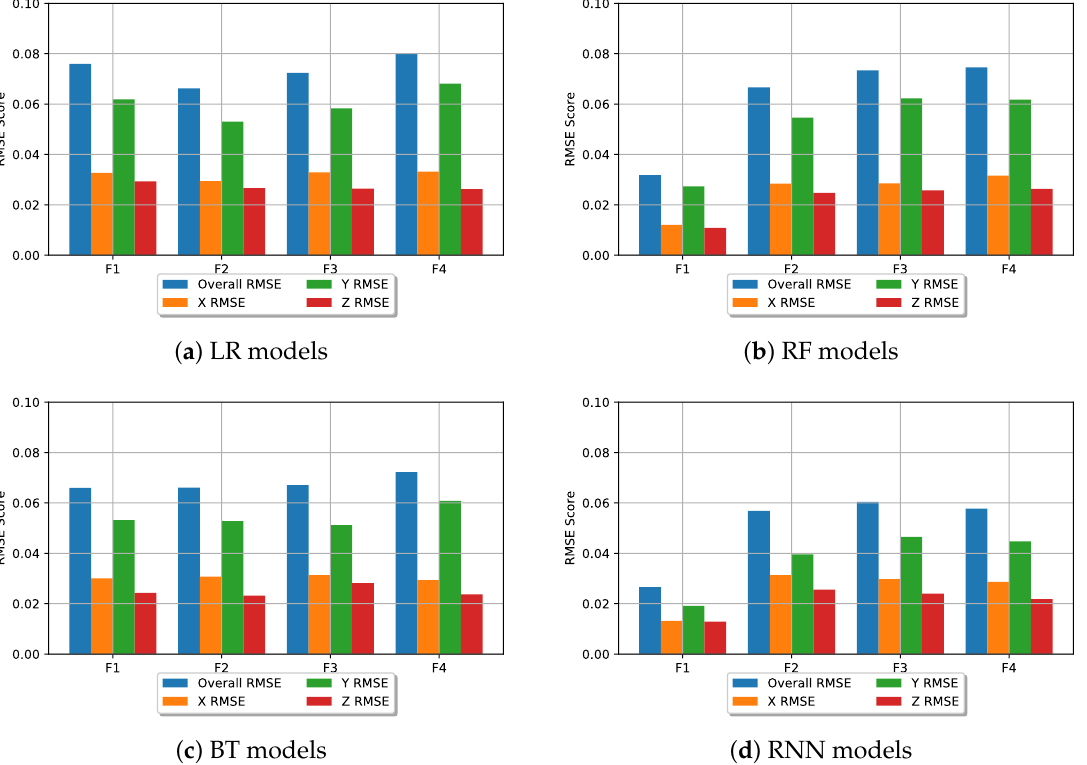
Figure 8. RMSE (root mean square error) scores of different models using the sets of features F1, F2, F3, and